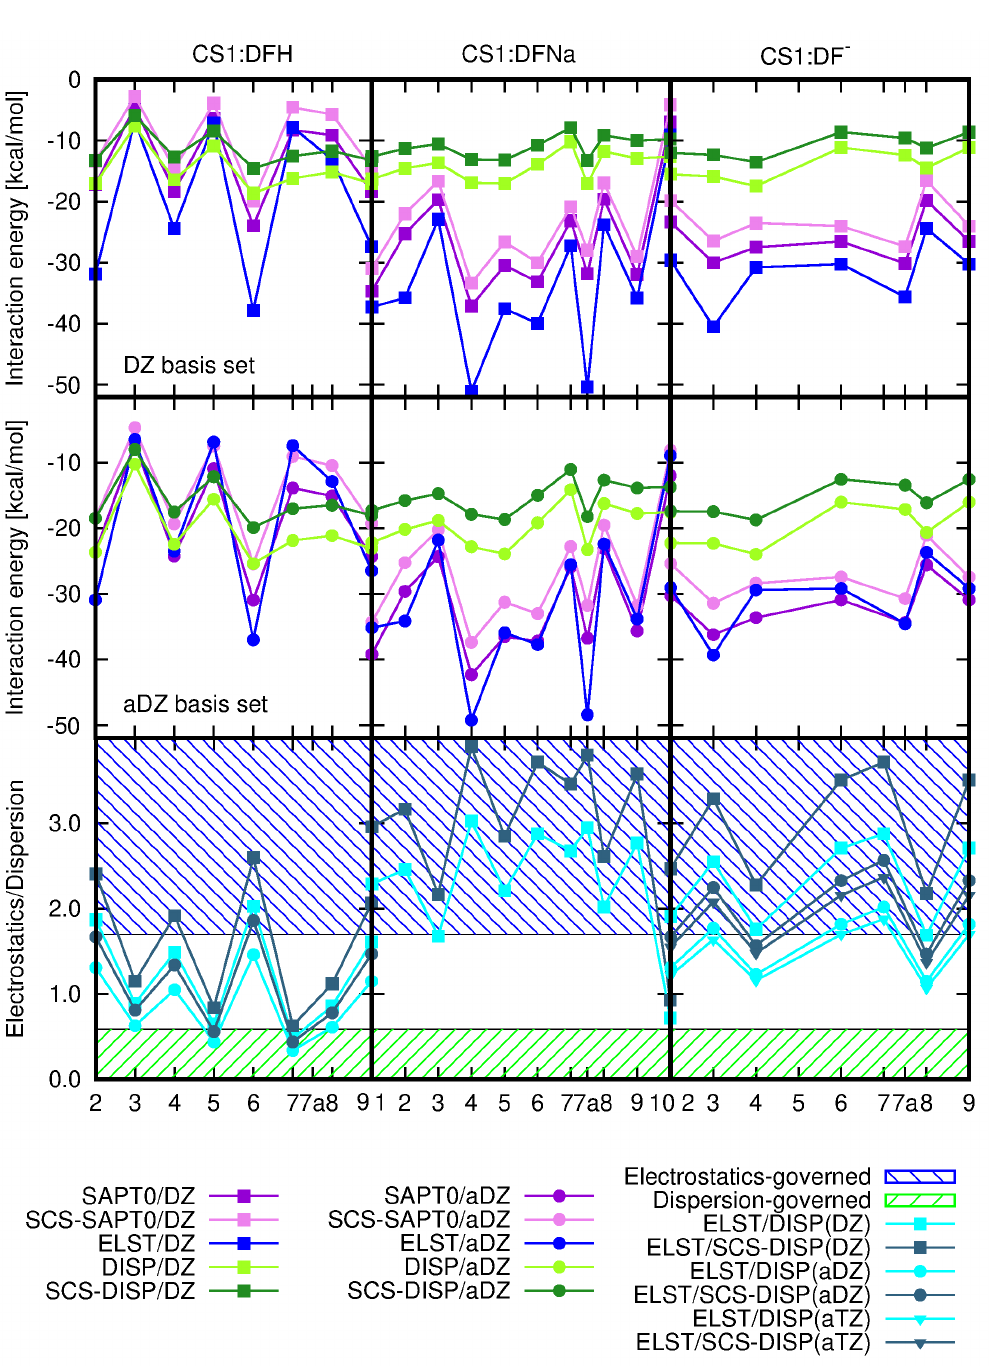
Figure 8. SAPT0 total interaction energy and electrostatic and dispersion components for investigated CS1:drug complexes and a relation between electrostatic and dispersion